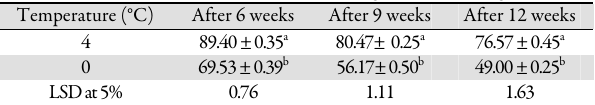
Table 6. Effect of different storage temperatures on plantlet regeneration from